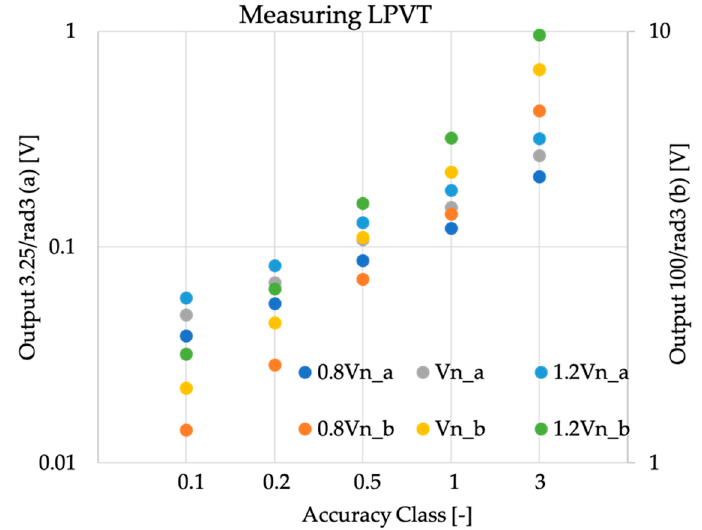
Figure 4. Absolute values of o computed from the rated outputs of Table 1 for measuring purpose voltage transformers.